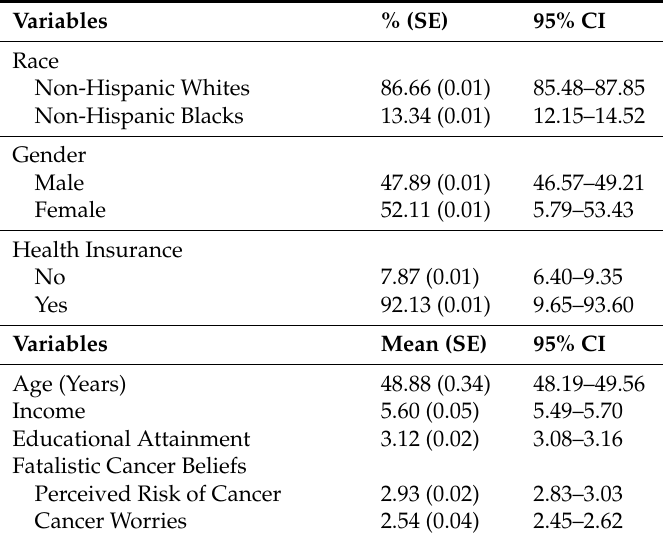
Table 1. Descriptive statistics of the participants.